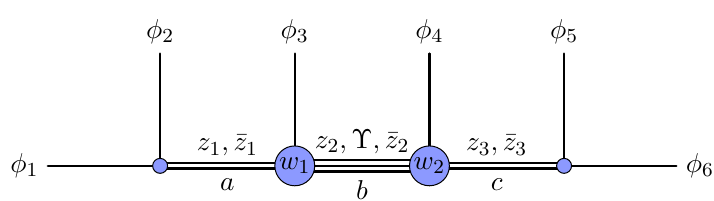
Figure 5 : Six point function with external scalars in the comb channel. The z Υ type of cross ratios are naturally associated with one particular internal leg or vertex of the OPE